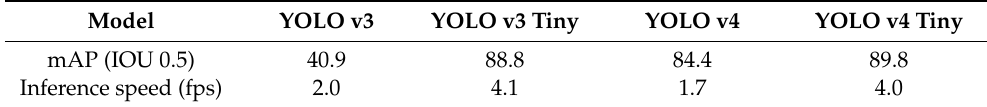
Table 4. Summary of model evaluation results.